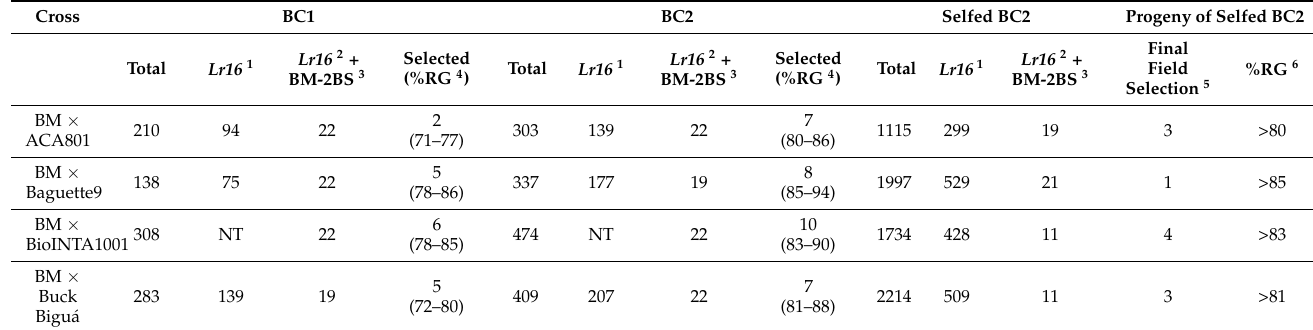
Table 5. Introgression into ACA801, Baguette9, BioINTA1001 and Buck Bigu á . Number of plants selected in each cycle. 1 Selected by seedling resistance to P. triticina race Ma07Bg9, 2 Selected by its associated marker wmc764, 3 Selected by genotyping codominant markers distributed on 2BS, 4 Percentage of recurrent parent genome, calculated as described in Materials and Methods, 5 Selected by rust resistance, phenotypic characteristics of height, plant architecture, stem thickness and spike size by comparison with the original commercial variety and homogeneity, 6 Minimum %RG according to the BC2 %RG, NT: Not tested.